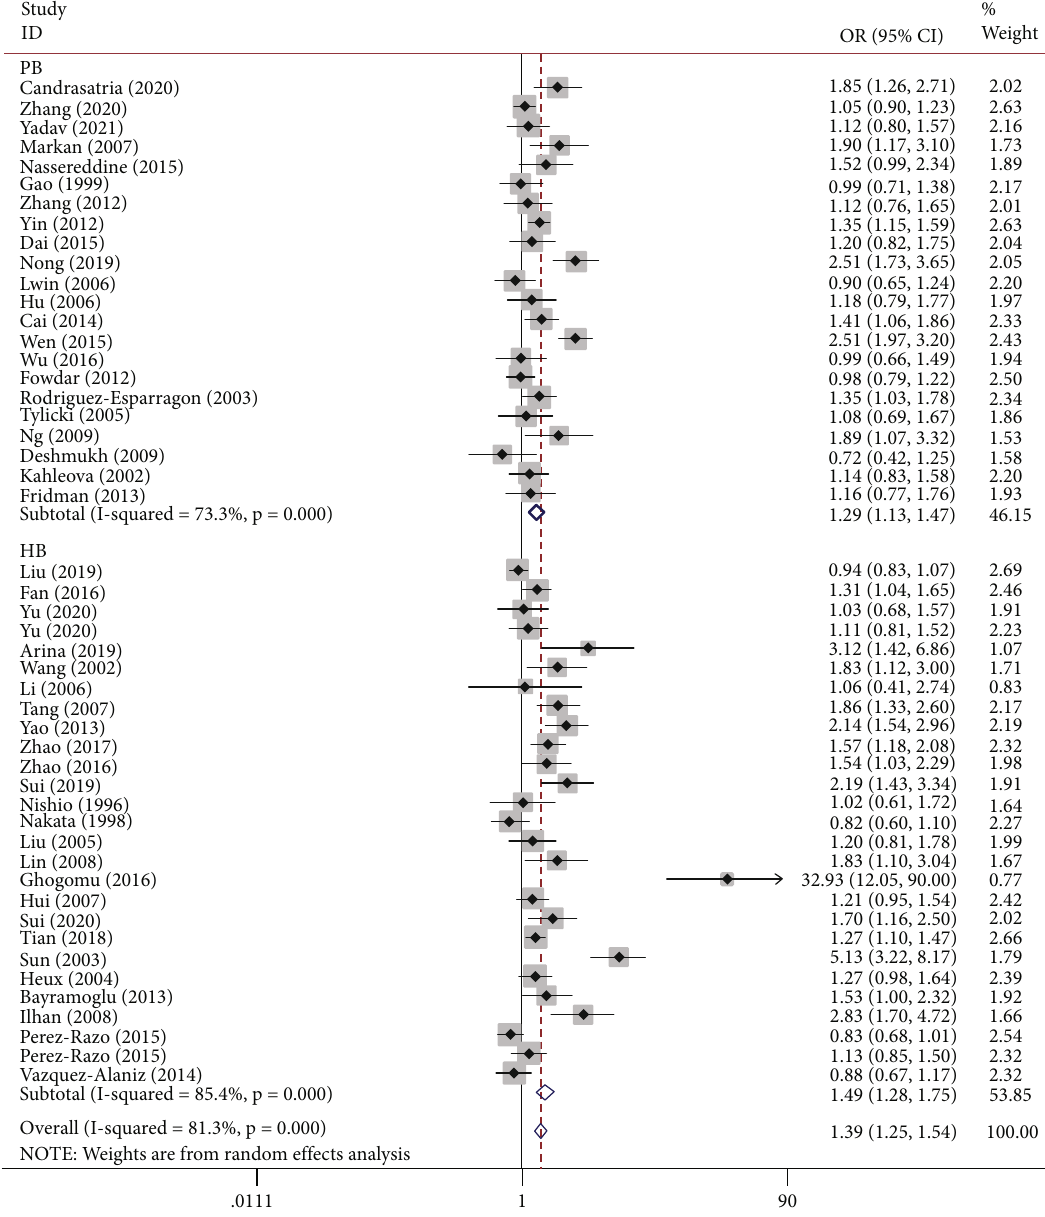
Figure 6: T-allele frequencies for the MTHFR gene rs1801133 polymorphism among cases/controls strati fi ed by subgroups in T-allele vs. C- allele model in source of control in the analyses of ethnic subgroups (T-allele vs. C-allele: < 0 : 001 , P < 0 : 001 , I 2 OR = 1 : 47 , 95% CI = 1 : 30 − 1 : 67 , P h = 83 : 2 % for Asians, Figure 4; OR = 1 : 28 , 95% CI = 1 : 05 − (Figure 6). As di ff erent methods for detecting this polymor- = 0 : 004 , P = 0 : 014 , I 2 = 64 : 2 % for Europeans, 1 : 57 , P phism were applied in all of the included studies, we consid- h ered whether positive results were associated with particular Figure 4; OR = 1 : 54 , 95% CI = 1 : 33 − 1 : 79 , P h < 0 : 001 , P < 0 : 001 , I 2 = 85 : 6 % for Chinese, Figure 5; and OR = 1 : 20 , genotyping methods. Our analyses revealed some signi fi cant fi ndings, such as PCR (T-allele vs. C-allele: OR = 1 : 51 , 95% 95% CI = 1 : 06 − 1 : 37 , P h < 0 : 001 , P = 0 : 004 , I 2 = 66 : 3 % for CI = 1 : 14 − 2 : 01 , P < 0 : 001 , P = 0 : 004 , I 2 = 86 : 1 %), PCR- non-Chinese). In order to analyze the source of controls h and determine the source of heterogeneity, the ratios were calculated for the HB and PB subgroups. The results showed signi fi cantly increased relationships in these groups (T-allele vs. C-allele: OR = 1 : 49 , 95% CI = 1 : 28 − 1 : 75 , P h < 0 : 001 , P